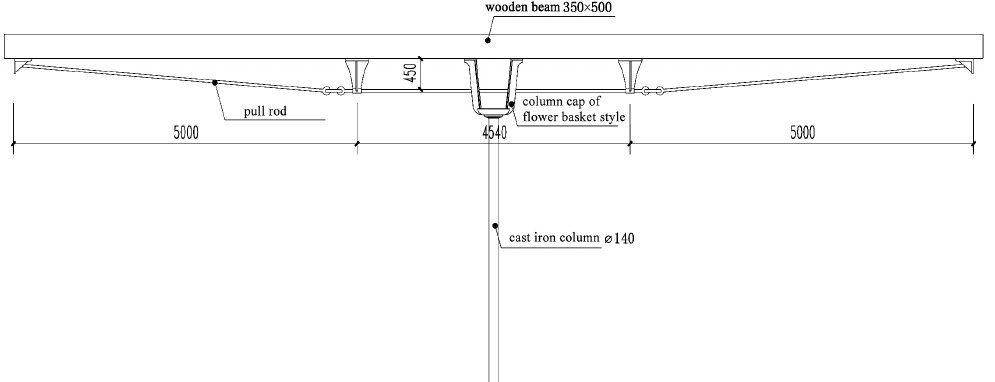
Buildings 2023 , 13 , x FOR PEER REVIEW Figure 9. Composite structure system of the first floor. Picture by X.X. Figure 9. Composite structure system of the first floor. Picture by X.X. Figure 9. Composite structure system of the first floor. Picture by X.X.